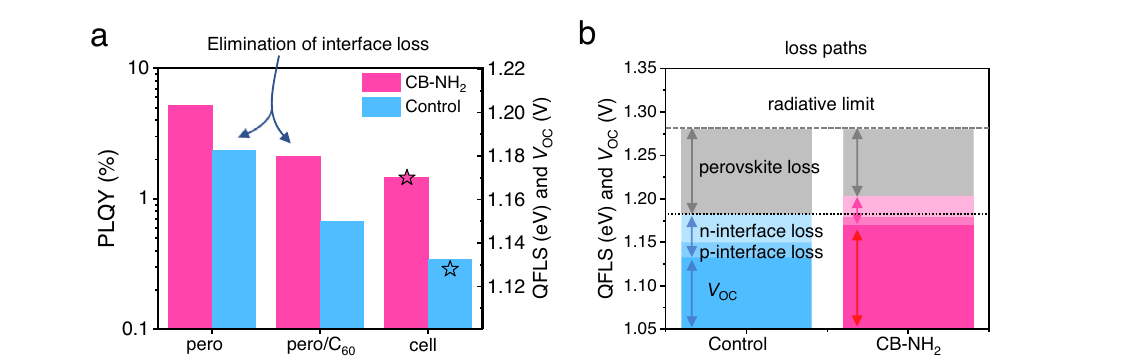
perovskite fi lm under gradually elevated temperature. c Maximum power point tracking undera 1-sun equivalentintensity of CB-NH 2 based and controlPSCs in an inert atmosphere at 26°C. Source data are provided as a Source Data fi